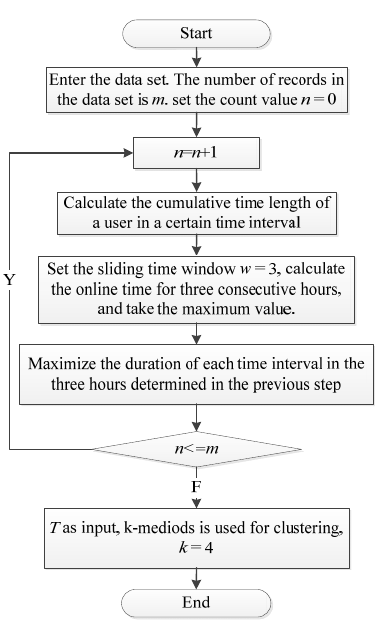
Figure 2. Online Behavior Preference algorithm flow chart.